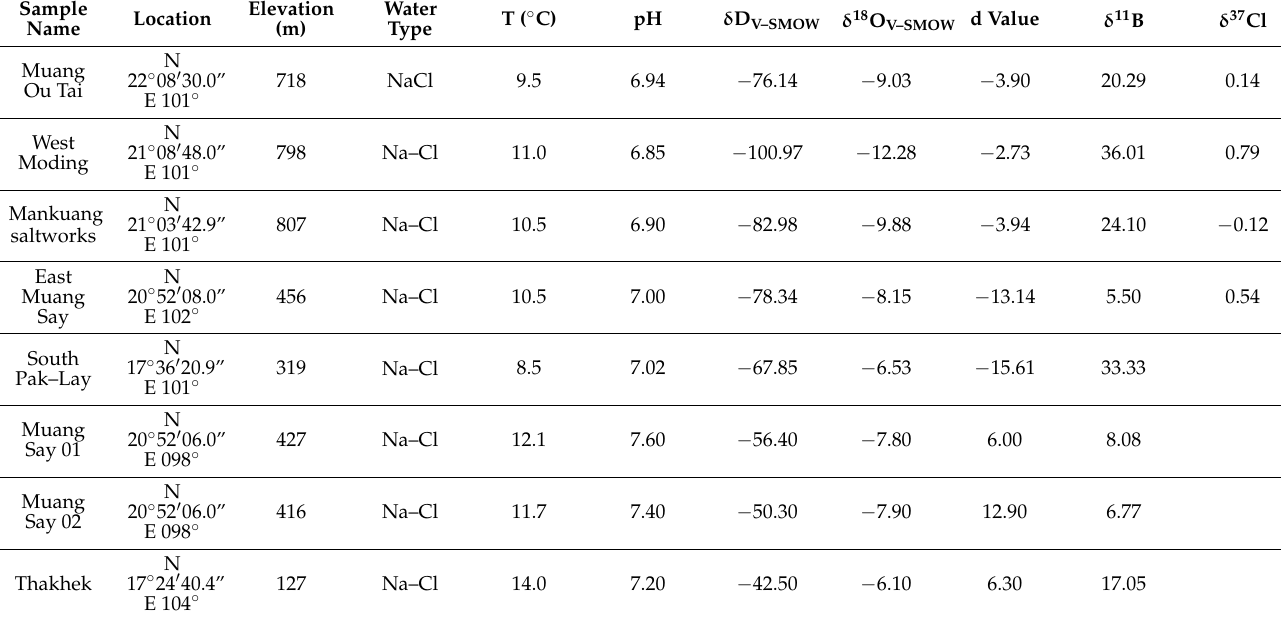
Table 2. Field observations, locations, water types, and isotope date of the saline springs in north and central